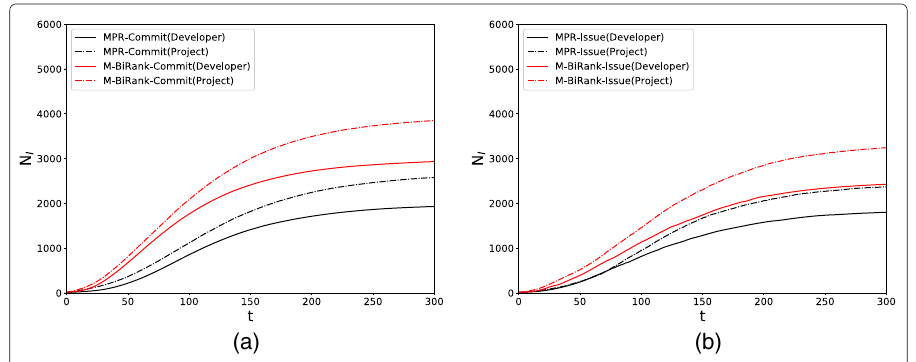
Fig. 7 Performance comparison between M-BiRank and MPR. The horizontal axis t indicates the number of iterations in SIR modeling. The vertical axis N I indicates the number of final infected nodes (developers or projects, including infected and removed